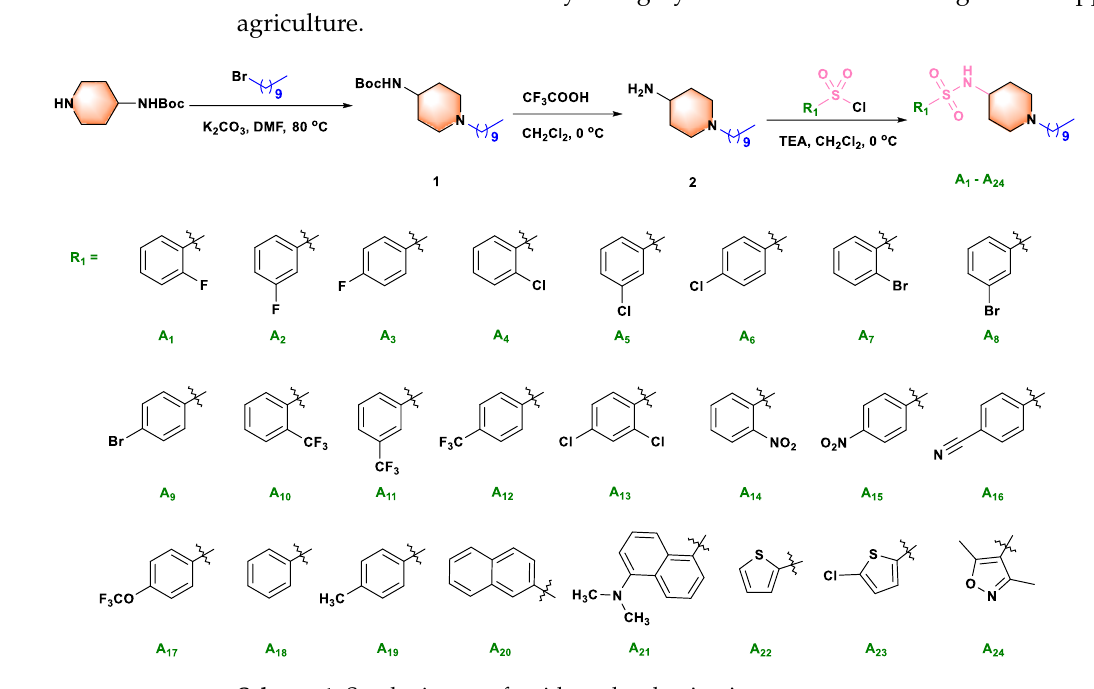
Scheme 1. Synthetic route for title molecules A 1 – A 24 Table 1. In vitro antibacterial activities of target compounds A 1 − A 24 against plant pathogens.